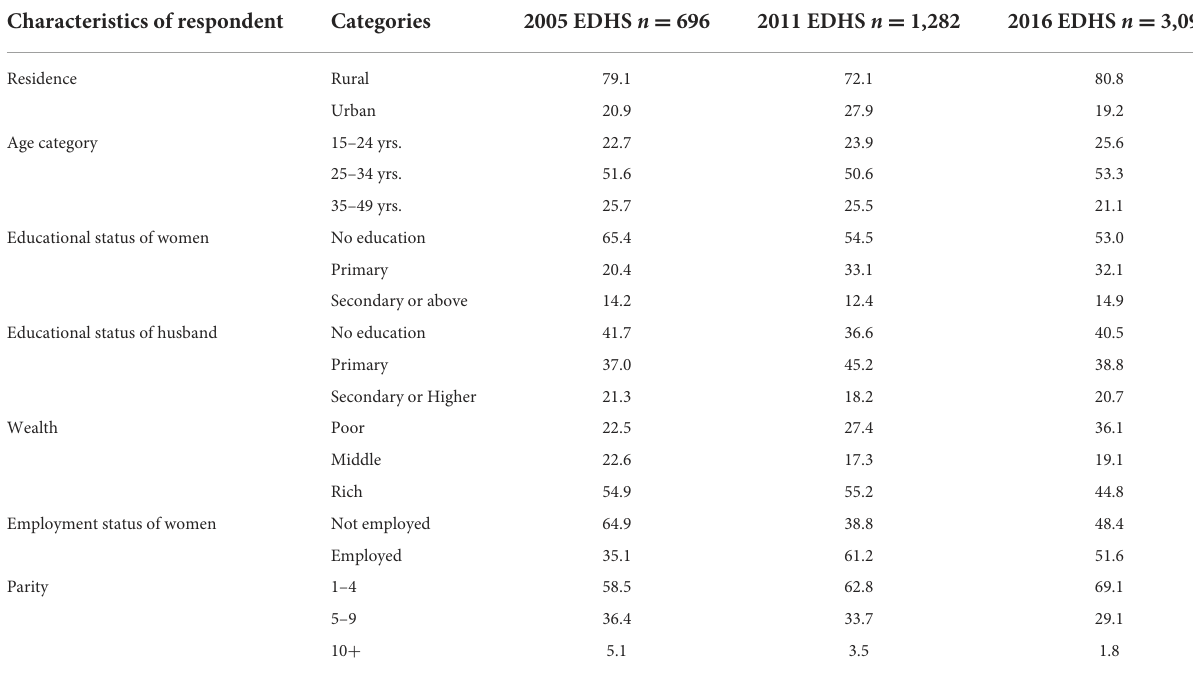
TABLE 1 Proportion of respondents by sociodemographic and socioeconomic characteristics in Ethiopia based on the EDHS 2005–2016.